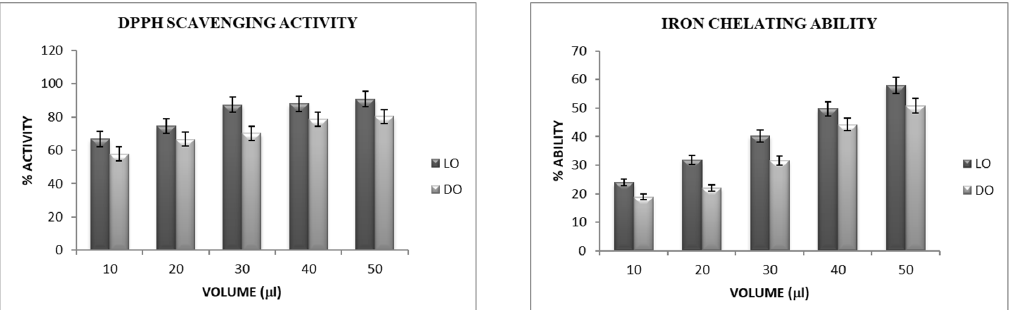
Figure 2. Antioxidant activities and correlation study of Dark essential oil (DHBH) and light essential oil (IDHBH) Symbols used: TPC: total phenolic content, TTC: total tannin content, DSA: DPPH scavenging activity, ICA: iron cheating activity. Values on bar are mean ± SD (n=3). * Indicates significant difference of light oil vs dark oil at P≤0.05 Dark oil (DHBH) R-square